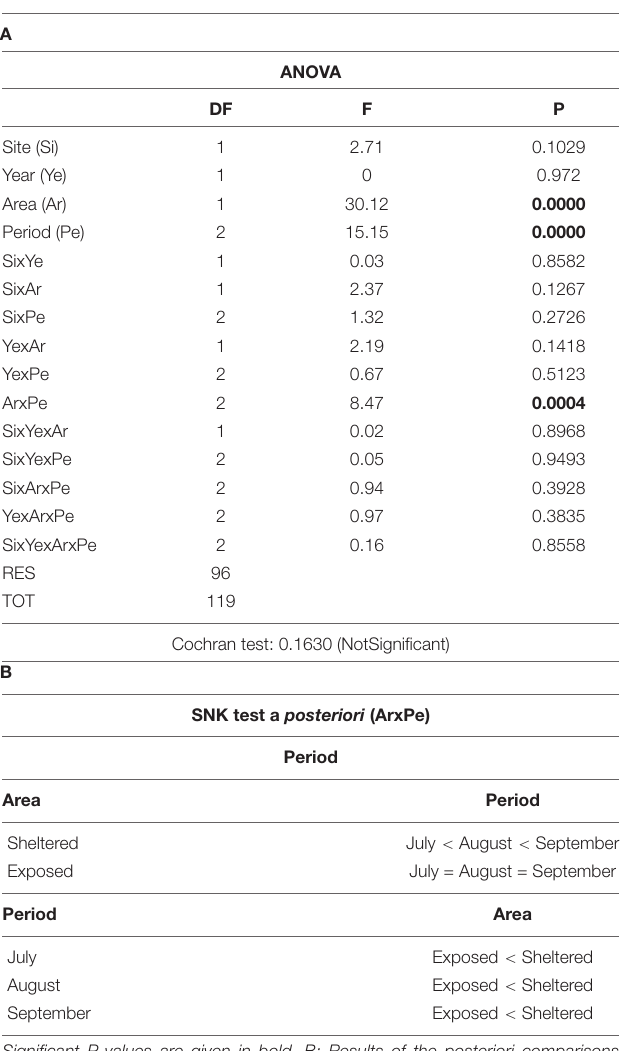
TABLE 1 | (A) Results of the ANOVA on data regarding the fertile thalli (FT)/total number of thalli (TT) ratio in relation to the considered factors: Site (Si): CB vs PT; Year (Ye): 2018 vs. 2019; Area (Ar): sheltered vs. exposed; Period (Pe): July vs. August vs.